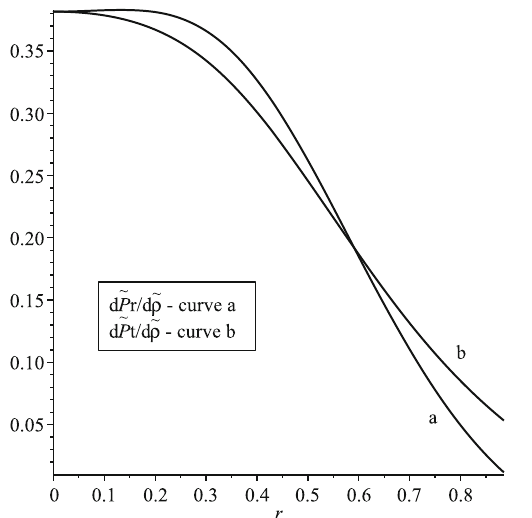
Fig. 6 Causality condition for the solution obtained with the first algo- rithm with F = 0 from the isotropic Gold III solution